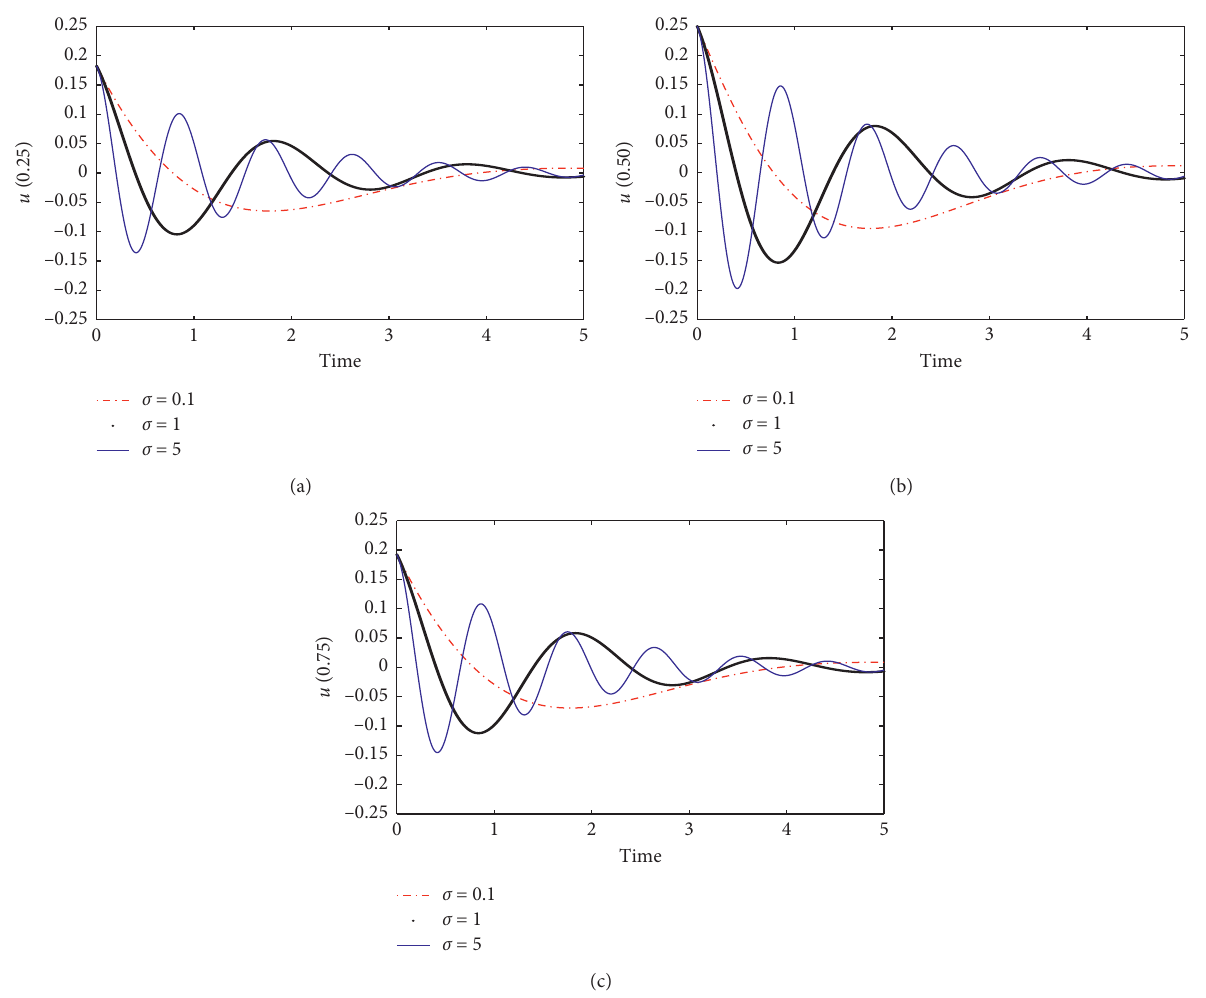
Figure 2: Test 2: damping behavior using the polynomial function g